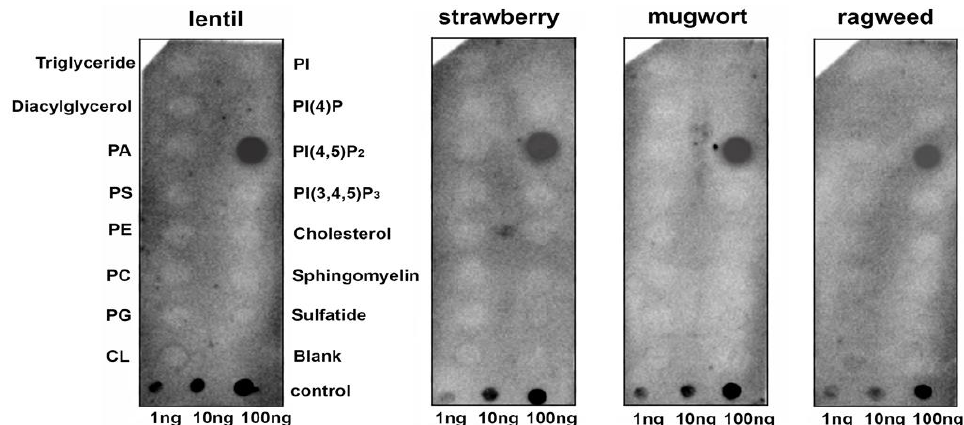
Figure 1. Lipid-binding assay of lipid transfer proteins (LTPs) from different plants using membrane lipid strips. PA, phosphatidic acid diC16; PS, phosphatidylserine diC16; PE, phosphatidylethanolamine diC16; PC, phosphatidylcholine diC16; PG, phosphatidylglycerol diC16; CL, 16:0 cardiolipin; Sulfatide, 3-sulfogalactosylceramide; PI, phosphatidylinositol diC16; PI(4)P, phosphatidylinositol (4)-phosphate diC16; PI(4,5)P2, phosphatidylinositol (4,5)-bisphosphate diC16; PI(3,4,5)P3, phosphatidylinositol (3,4,5)-trisphosphate diC16.